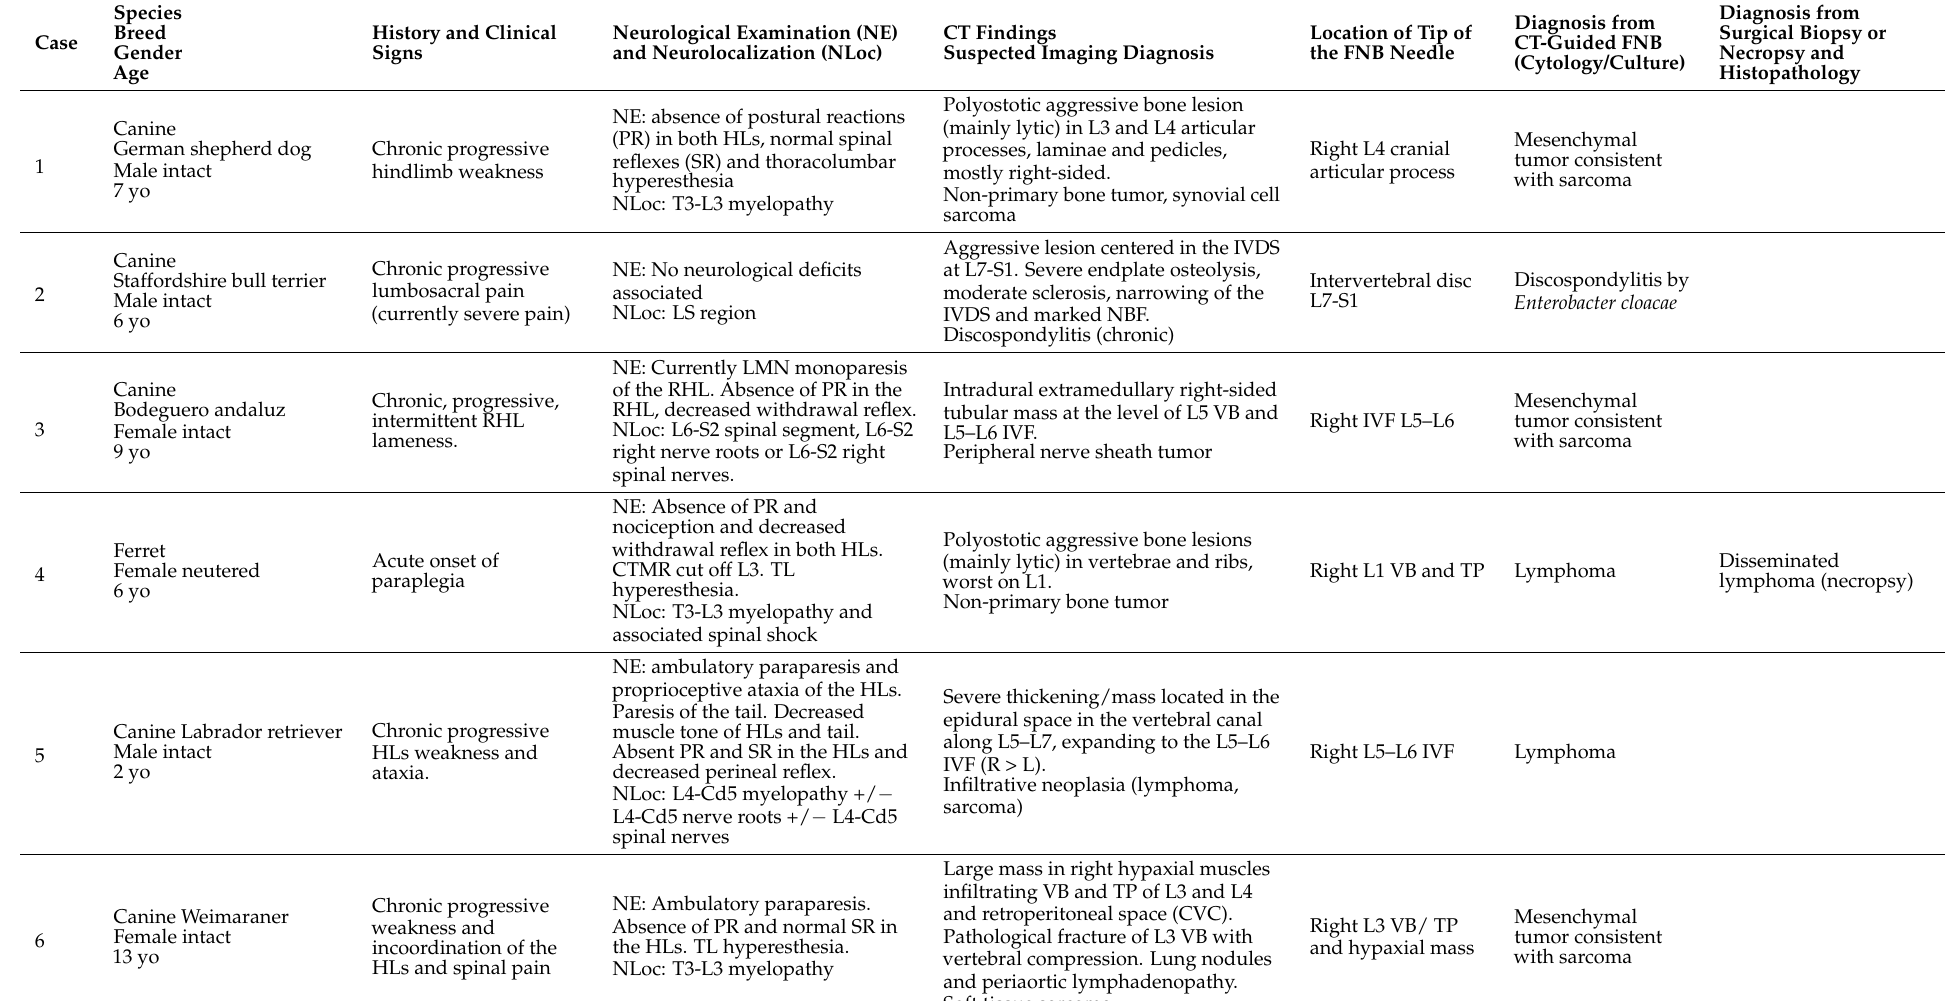
Table 1. Results of the free-hand CT-guided fine needle biopsies (FNB) in 10 dogs and 1